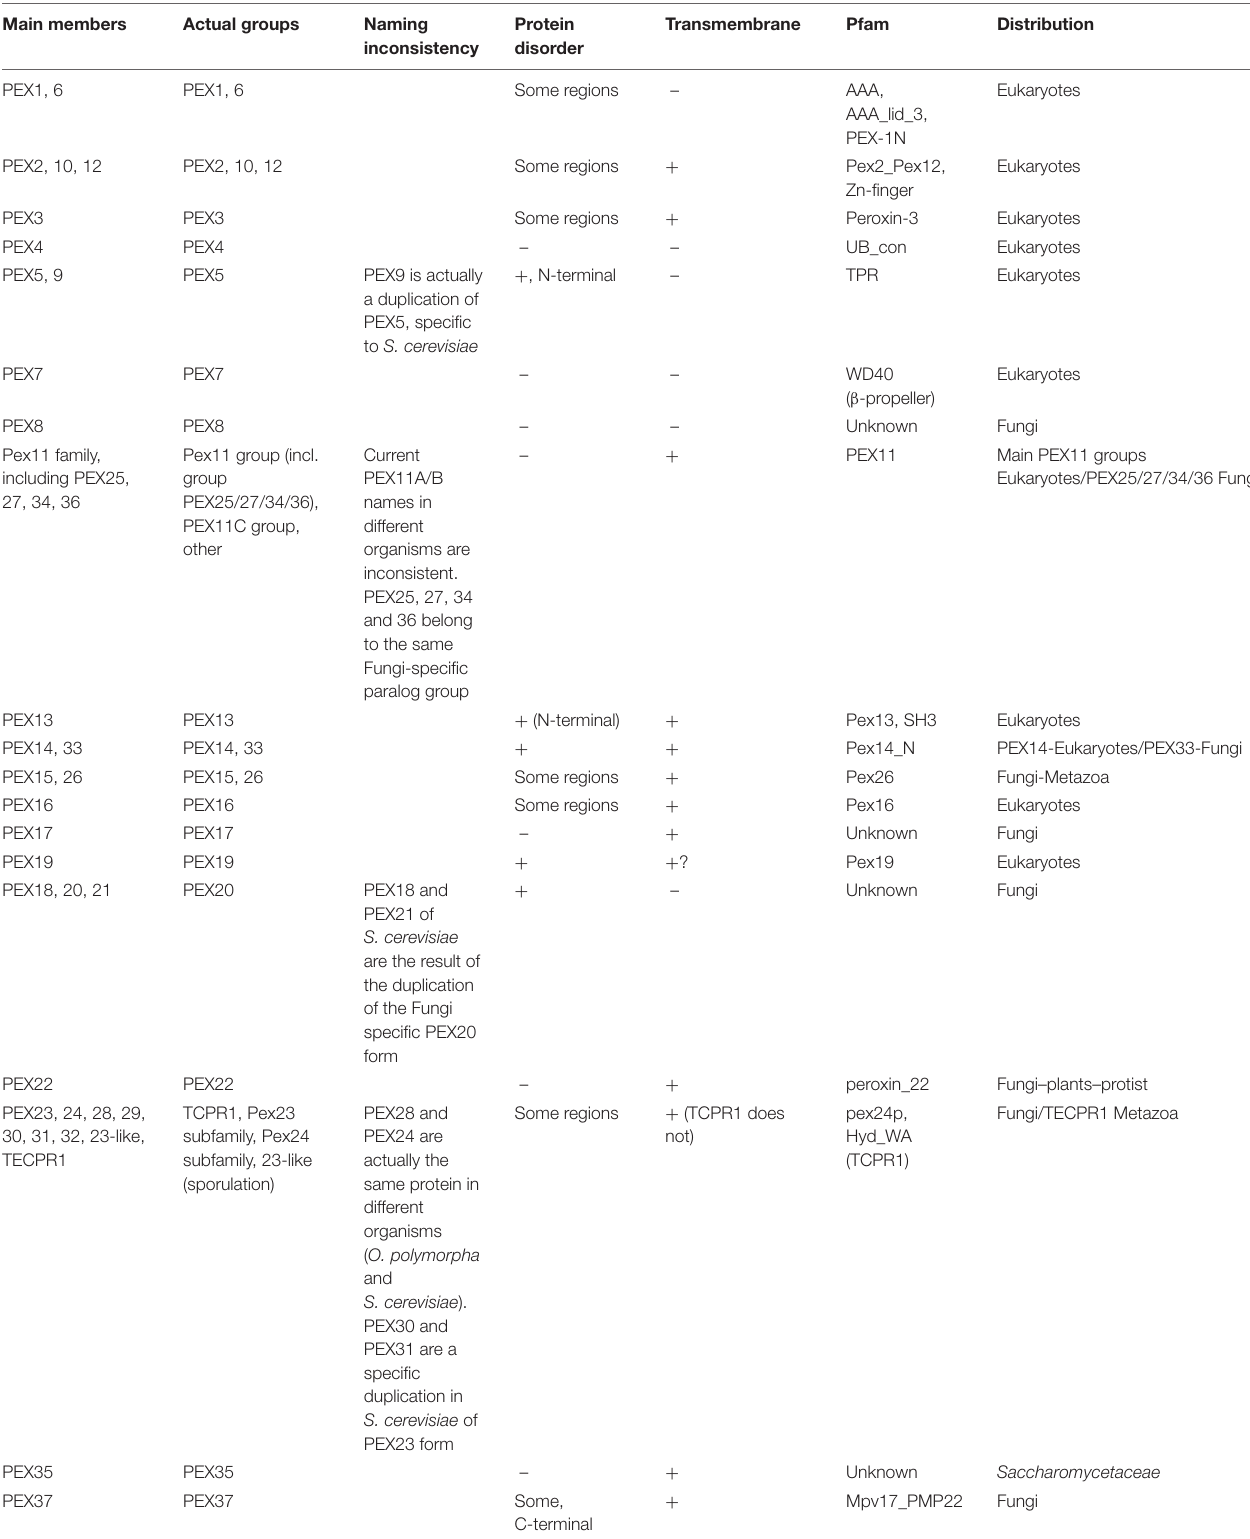
TABLE 2 | Overview of PEX proteins and their main